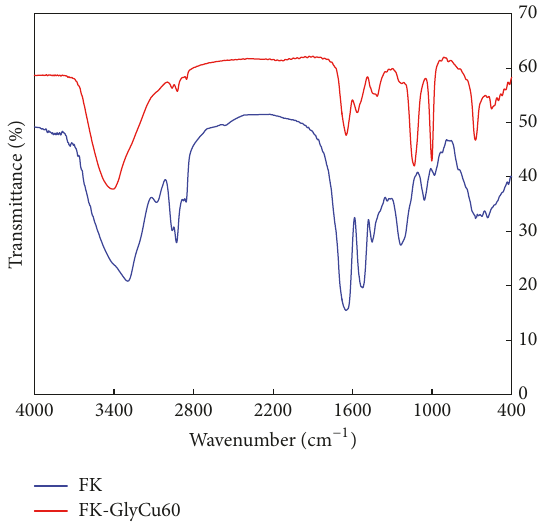
Figure 1: The IR spectra of FK-GlyCu 60 complex.